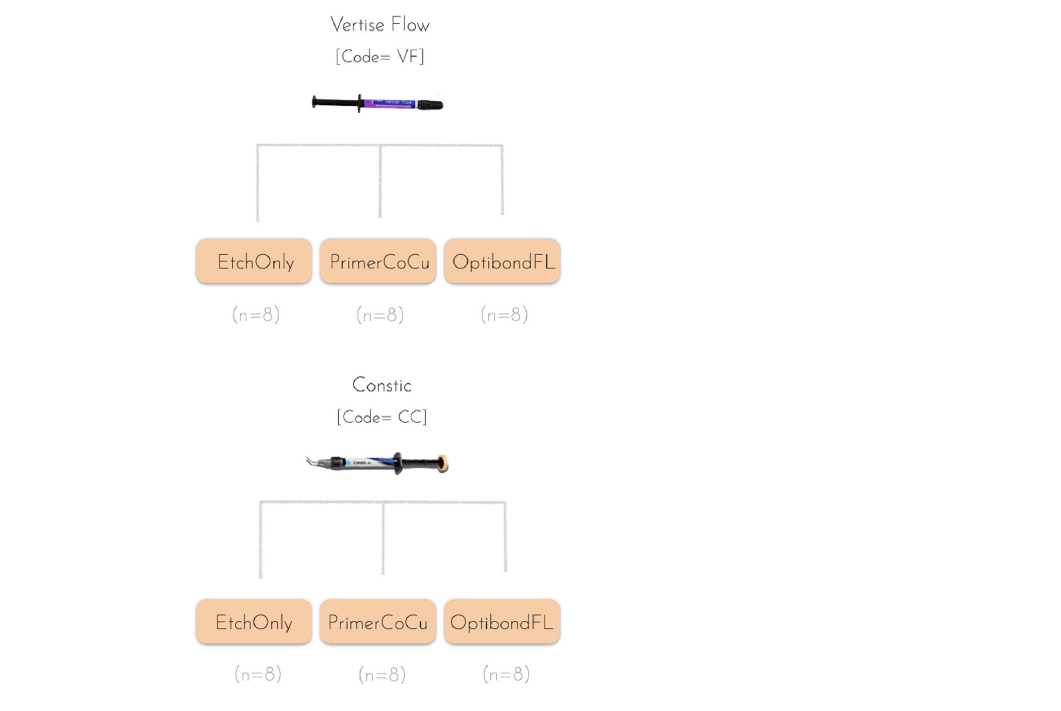
Figure 1. Experimental design followed in this study, with two distinct material groups, Vertise Flow (VF) and Constic (CC), each subdivided into three experimental groups based on the bonding strategy used (Table 2). Table 2. Step-by-step procedure carried out during sample preparation, considering the three bonding strategies evaluated in this study.